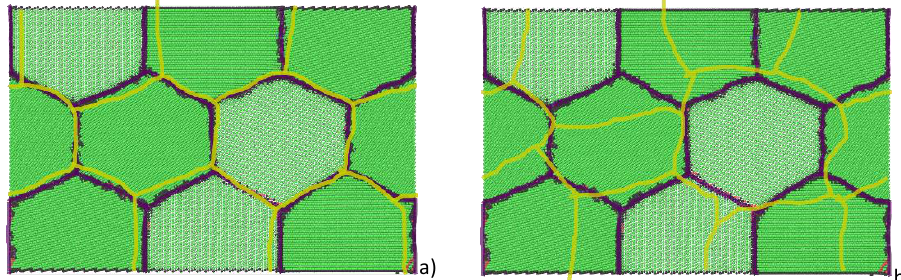
Fig. 5. Grain structure at time points: a) 175 and b) 700 ps. The initial position of the grain boundaries is shown in black, current one in